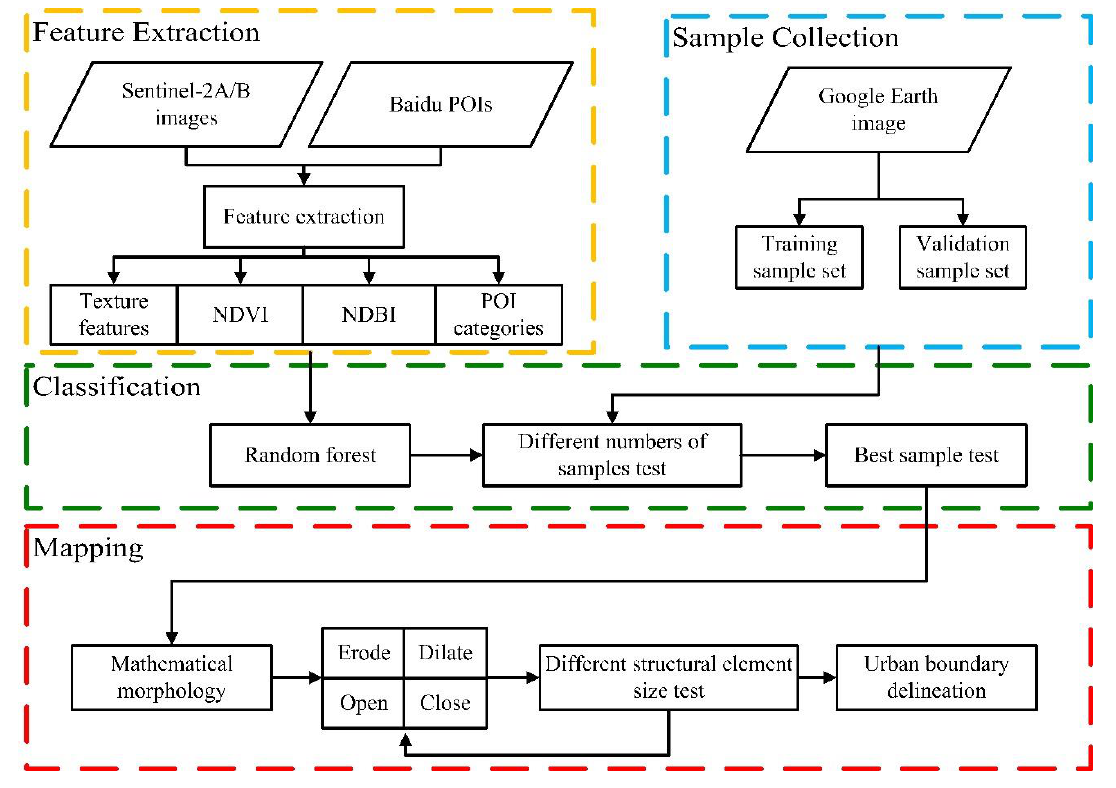
Figure 3. The workflow of the urban area extraction method proposed in this study.